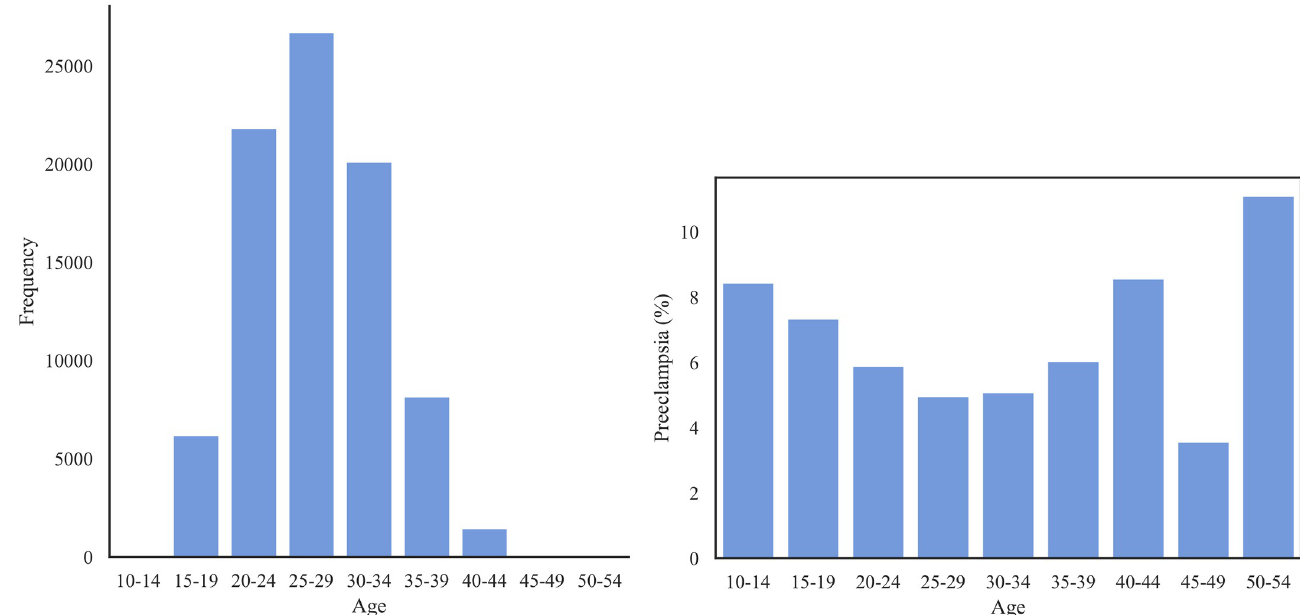
Fig 5. Left: The distribution of age group in the Oklahoma PUDF—Right: The prevalence of PE (%) for each age group.